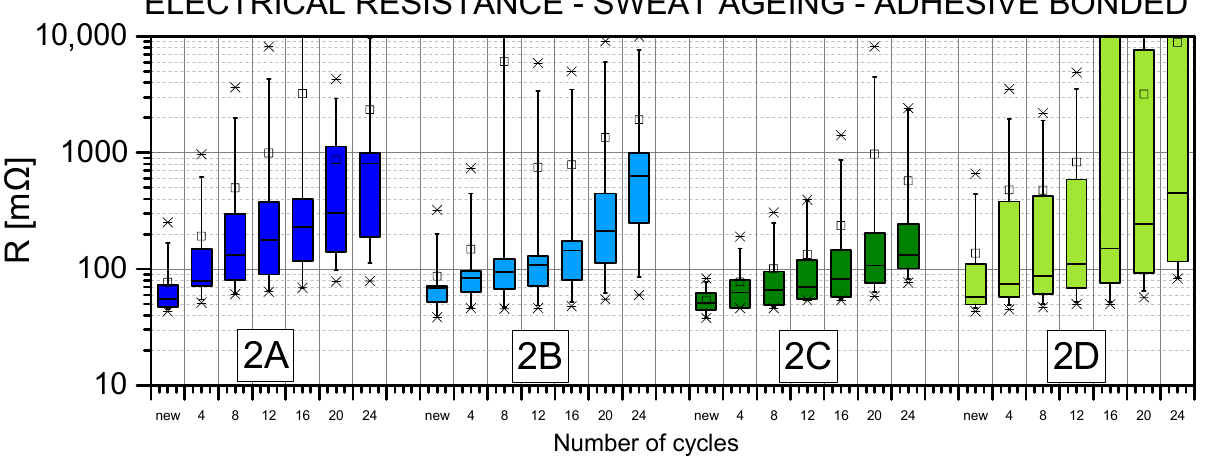
Figure 7. Boxplot diagram of adhesive ‐ bonded joint (second sample type) electrical resistance for samples 2A, 2B, 2C and 2D.